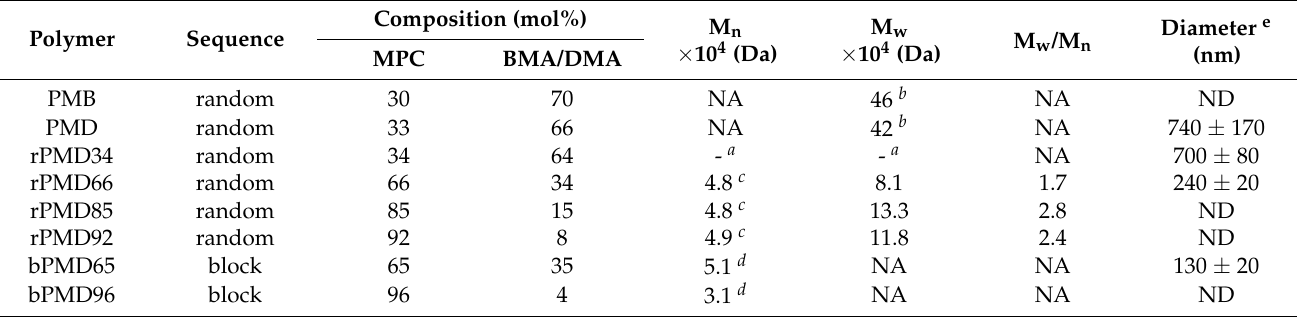
Figure 1. Chemical structure of poly(2-methacryloyloxyethyl phosphorylcholine (MPC)-co-n-butyl methacrylate) (PMB) (x = 3) and poly(MPC-co-dodecyl methacrylate) (PMD) (x = 11) and paclitaxel (PTX), and the self-assembly of MPC polymers. The compositions of each monomer (n and m) in PMB and PMD are shown in Table 1. Table 1. PMB and PMDs used in this